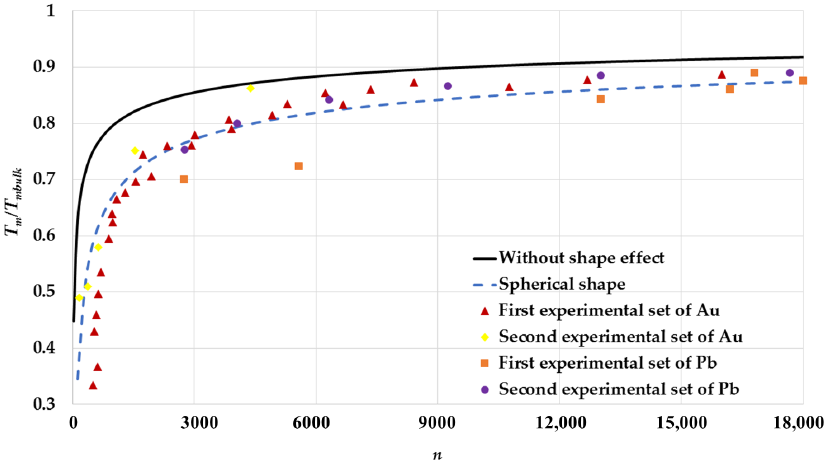
Figure 3. The variation of ratio 𝑇 𝑚 𝑇 𝑚𝑏𝑢𝑙𝑘 ⁄ as function of the number of atoms 𝑛 of spherical nanoparticles in an FCC structure is compared to without shape effect case that is based on Qi et al. model [34], two different experimental sets of Au nanoparticles: The first experimental set of Au [2] and the second experimental set of Au [5], and two different experimental sets of Pb nanoparticles: The first experimental set of Pb [6] and the second experimental set of Pb [7].